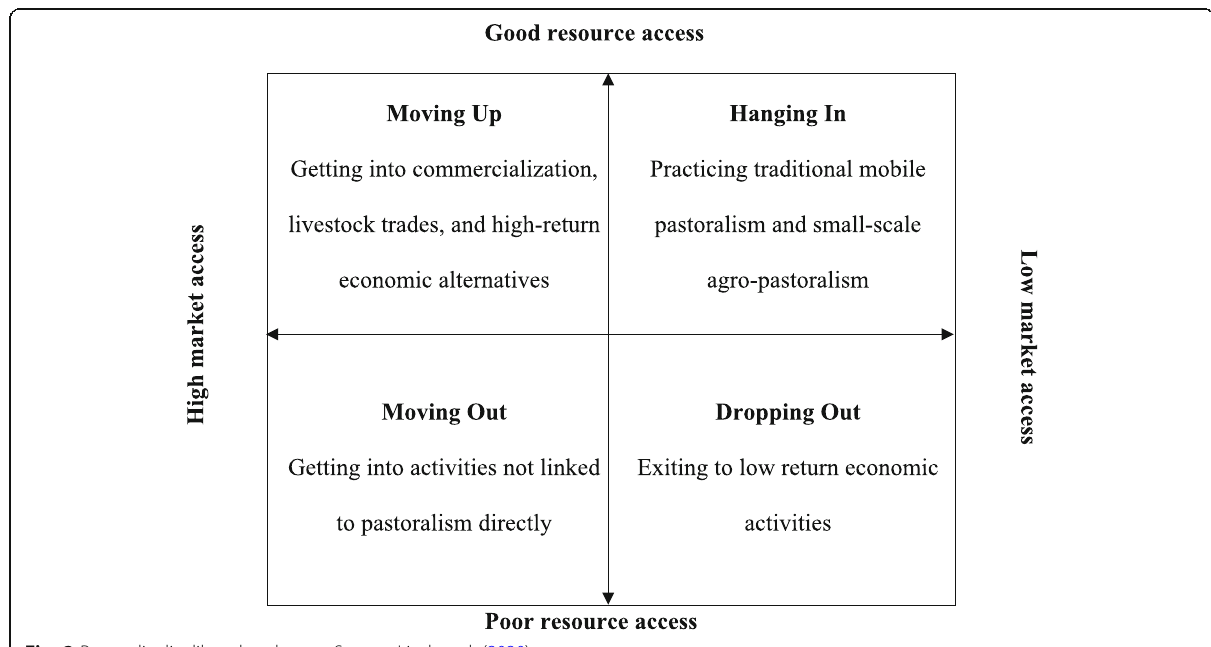
Fig. 2 Pastoralist livelihood pathways. Source: Lind et al.